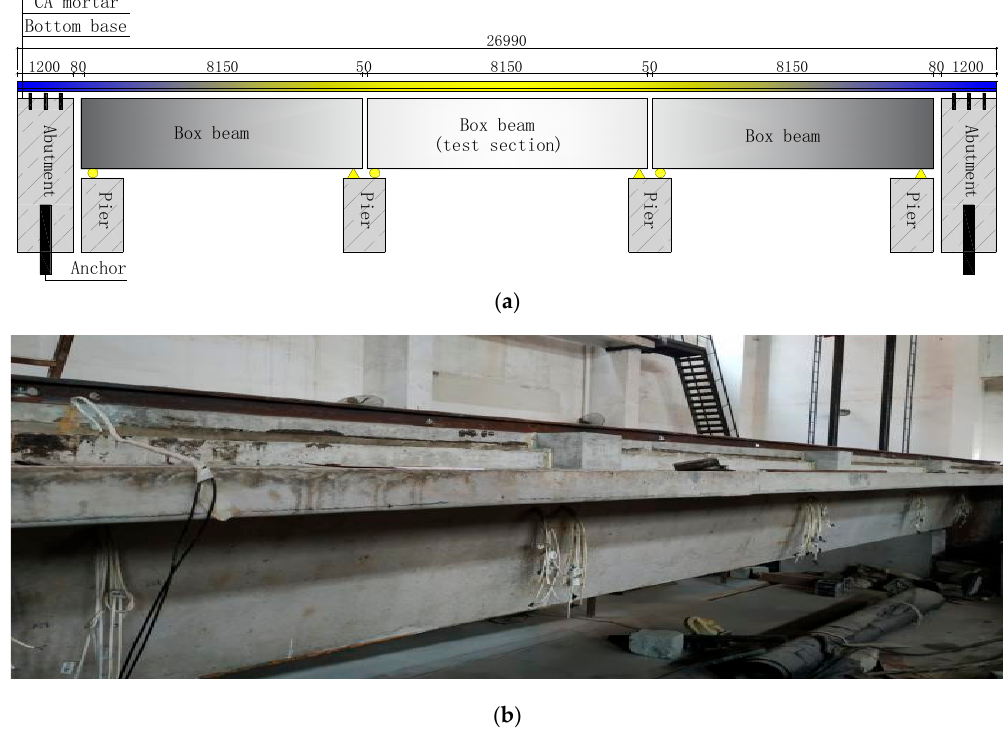
Figure 2. Three-span simply supported beam. ( a ) Facade design drawing of the model (Unit: mm); ( b ) scaled model diagram (Test